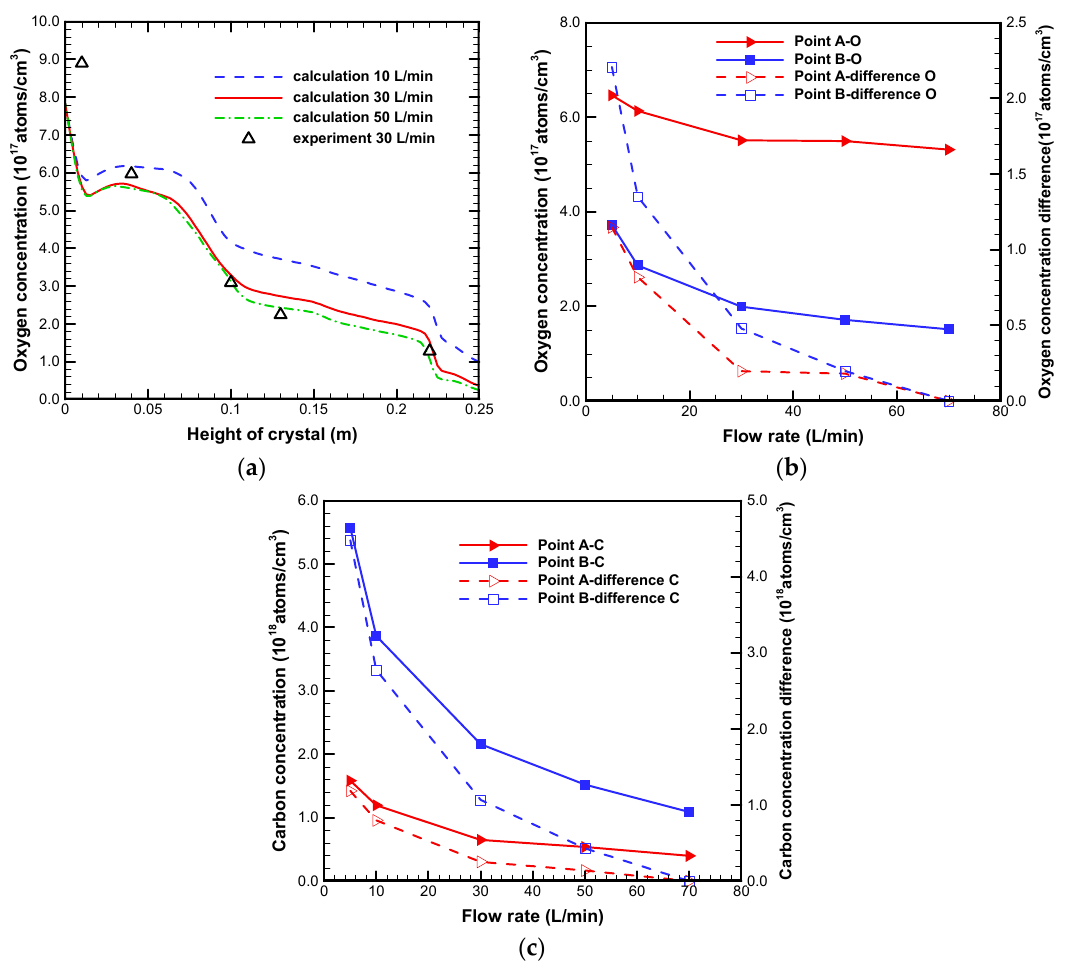
Figure 6. Oxygen concentration along the centerline of the solidified ingot ( a ), and the concentration and concentration differences of oxygen ( b ) and carbon ( c ) at Point A and Point B of the solidified ingots for different argon flow rates.